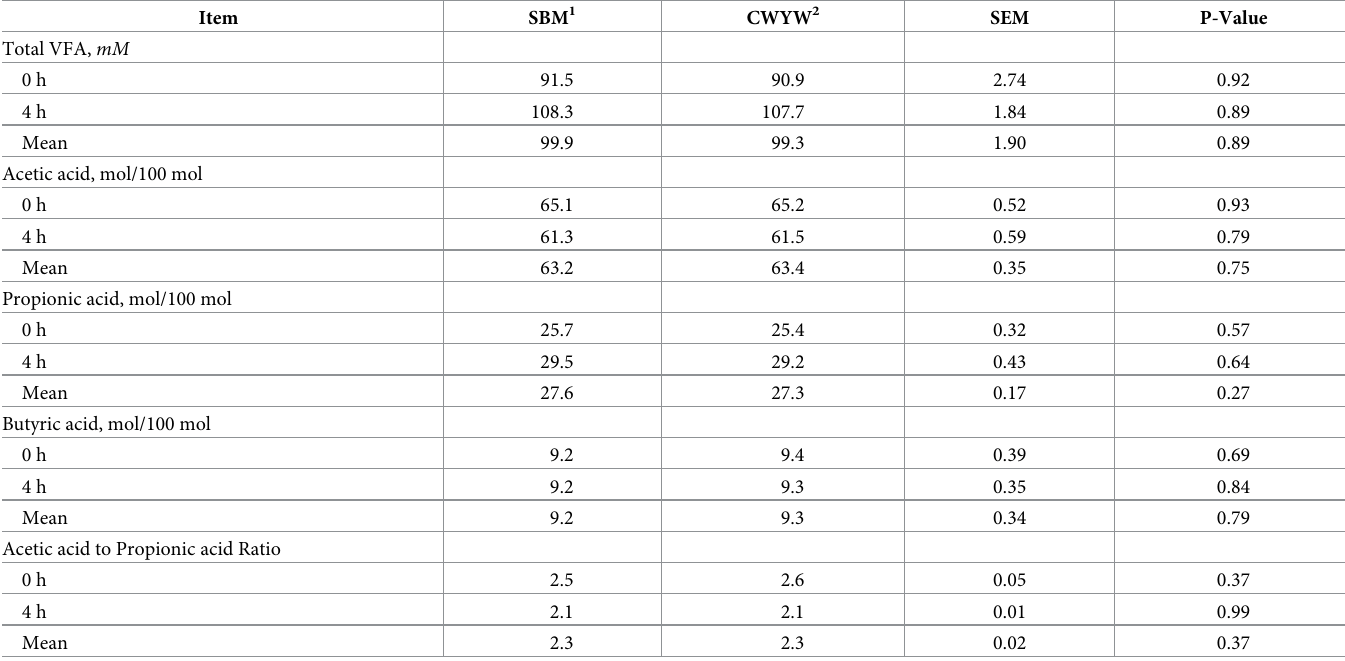
Table 4. Effect of replacing soybean meal with citric waste fermented yeast waste on volatile fatty acids (VFAs).